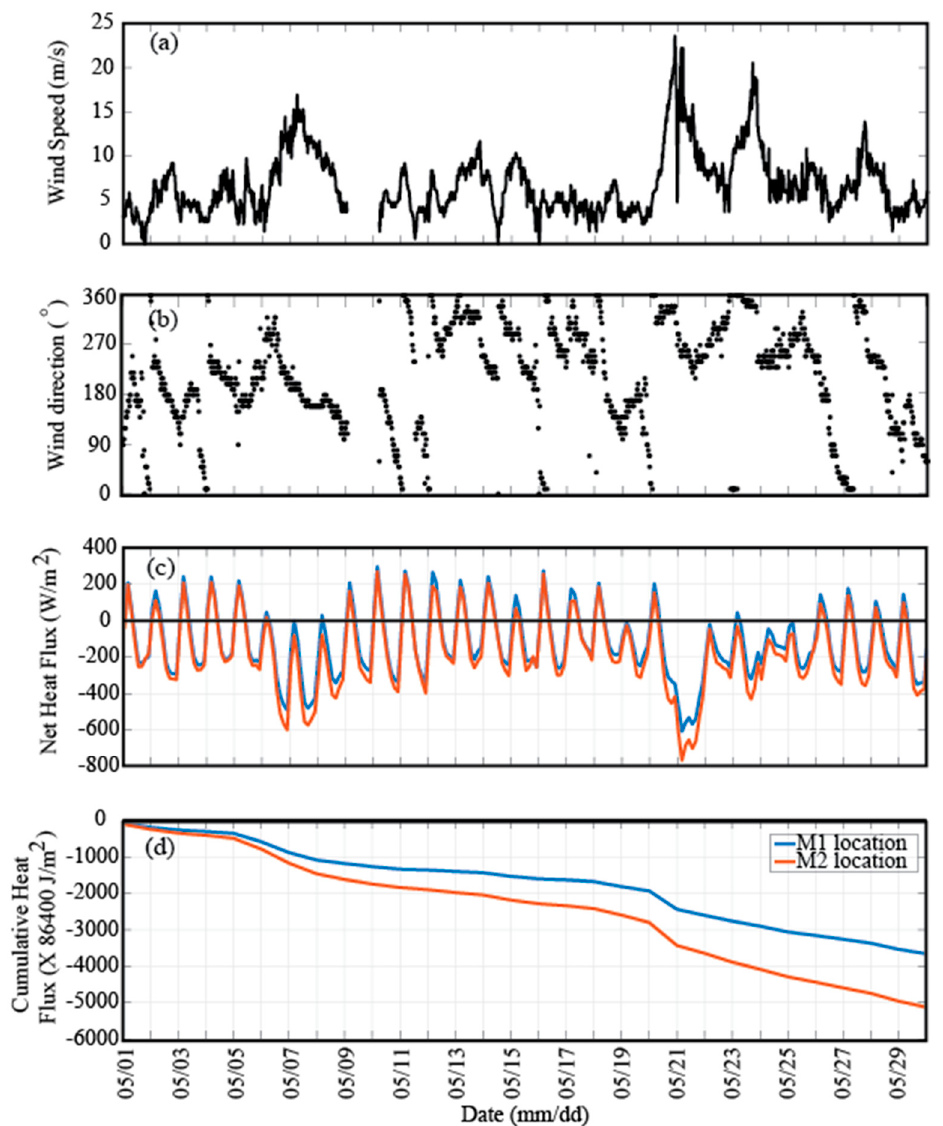
Figure 2. Time series of: ( a ) wind speed, ( b ) wind direction, ( c ) net heat flux, and ( d ) cumulative heat flux during May 2016. A negative value in net heat flux defined an upward flux or cooling, and a positive value defined a downward flux or heating. Note that the tick marks on the time axis are at 4 a.m. (UTC) corresponding to 12 noon (local time).